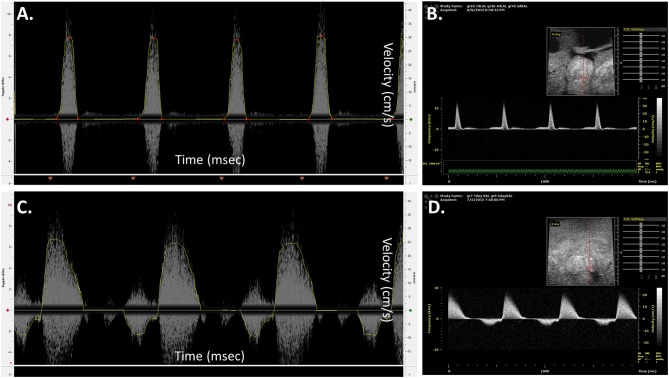
Chick embryo blood flow velocity waveforms obtained by mice Doppler system (A,C) and Visualsonics in vivo 770 platform (B,D). The waveforms were measured at the atrioventricular (A,B) and outflow track canals (C,D). The data obtained by both platforms compares well. The spectrograms from the mice Doppler system (A,C) shows a mirroring shadow of the recorded signal. The analysis software, however, recognizes this and detects only the correct signal, traced in a yellow line.